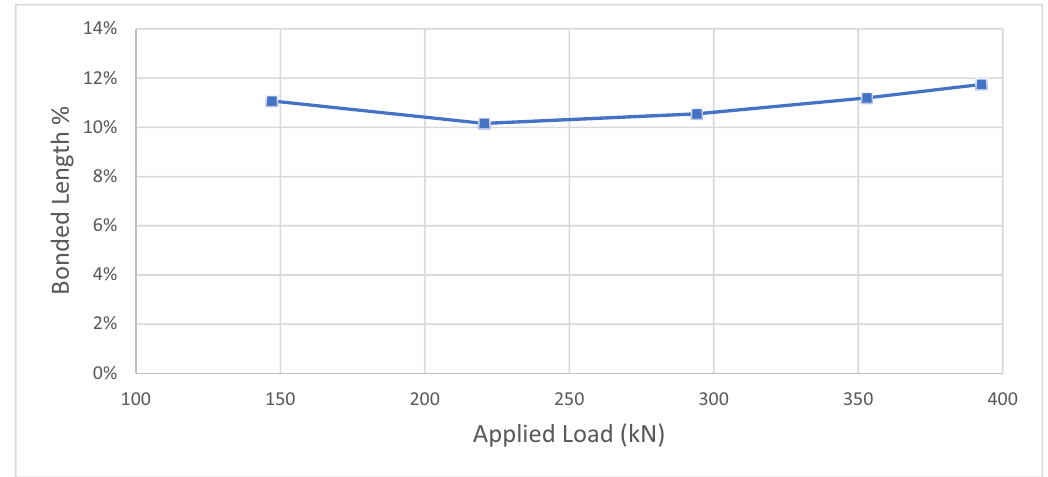
Figure 20: Location of the transition point as a percent of the bonded